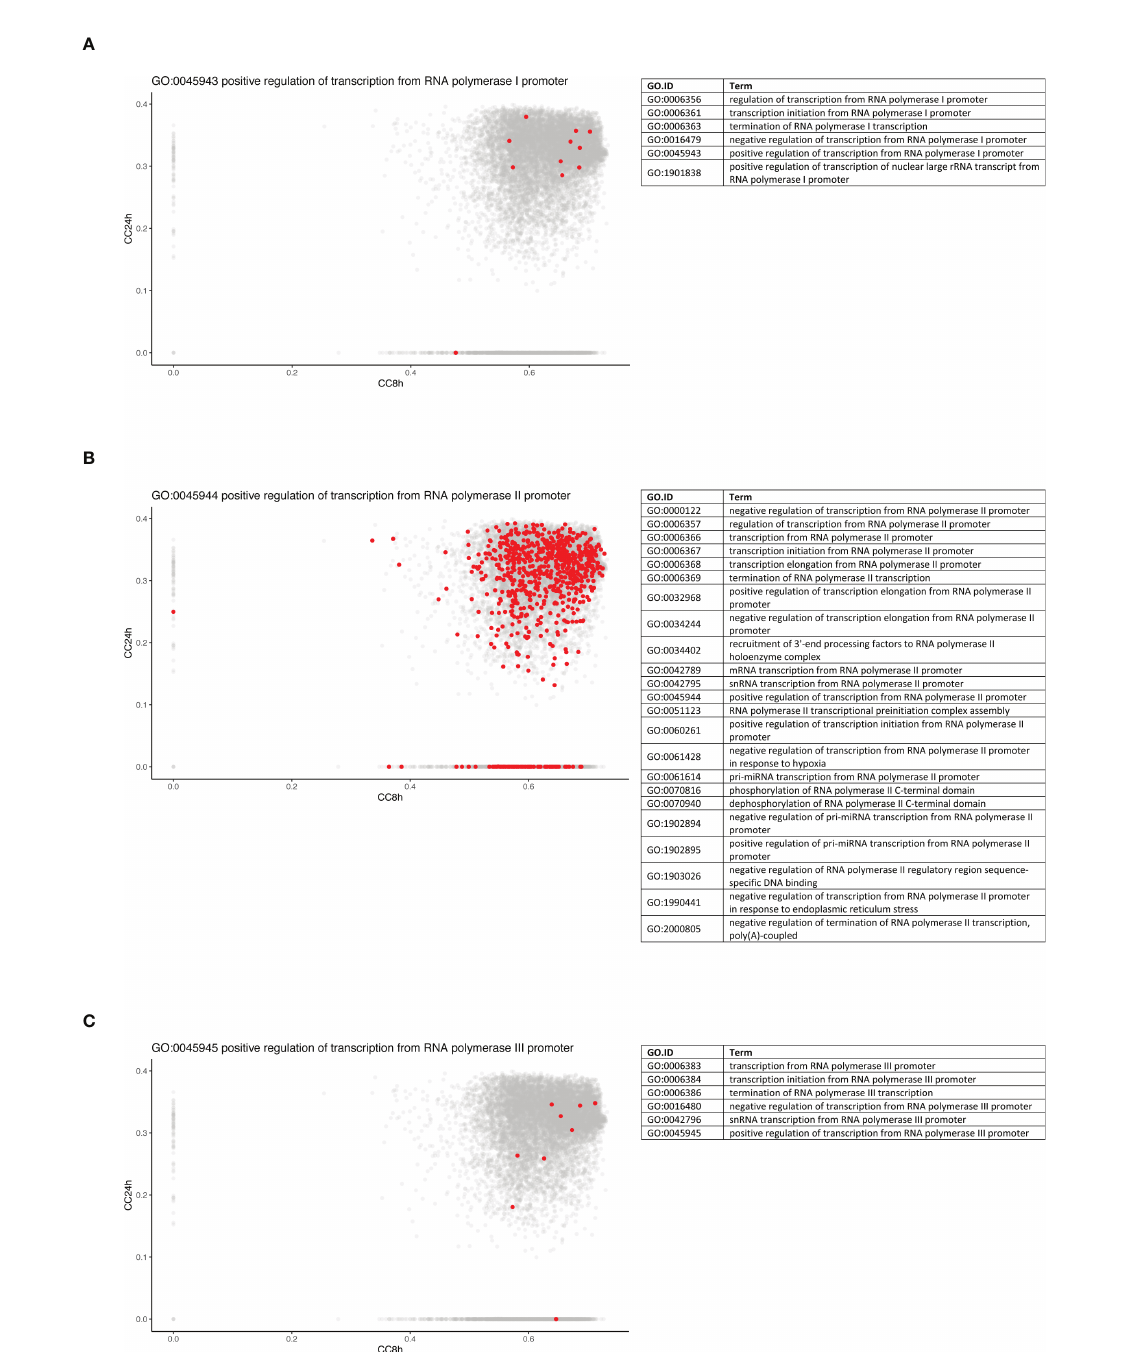
FIGURE 6 Genes from RNA polymerase II pathway are predominantly central at early time point. Density plots of the CC of genes in the WGCNA network at 8 h (x-axis) against 24 h (y-axis) in WT + Ifnar -/- analysis. Genes belonging to the examples of RNA polymerase I (A) , II (B) , and III (C) processes are highlighted in red. The lists of GO terms found for RNA polymerase I (Table A), II (Table B), and III (Table C) keywords are